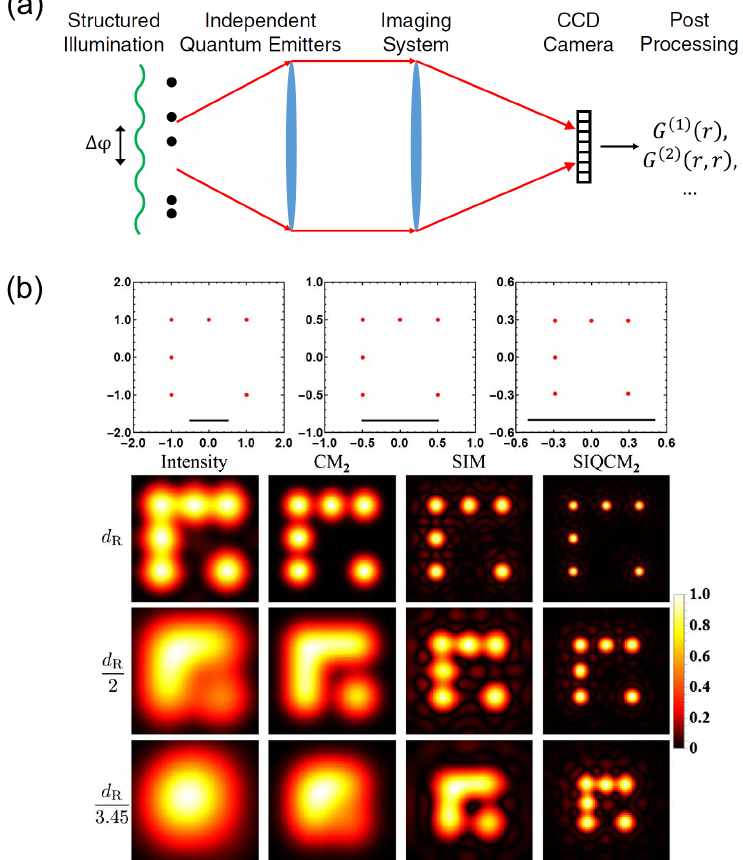
Figure 12. ( a ) Schematic of the structured illumination quantum correlation microscopy (SIQC) for fluorescence imaging. The super-resolution effect is greatly enhanced by combining the structured illumination and the quantum antibunching correlation; ( b ) Super-resolution imaging with SIQC at the second-order correlation (column indicated by SIQCM 2 ). The enhanced super-resolution with SIQCM 2 is clearly seen by comparing with the conventional intensity images (column indicated by intensity), the second-order cumulant super-resolution images (column indicated by CM 2 ), and the structured illumination induced super-resolution images (column indicated by SIM). The figure is reproduced with permissions from Ref. [44] of